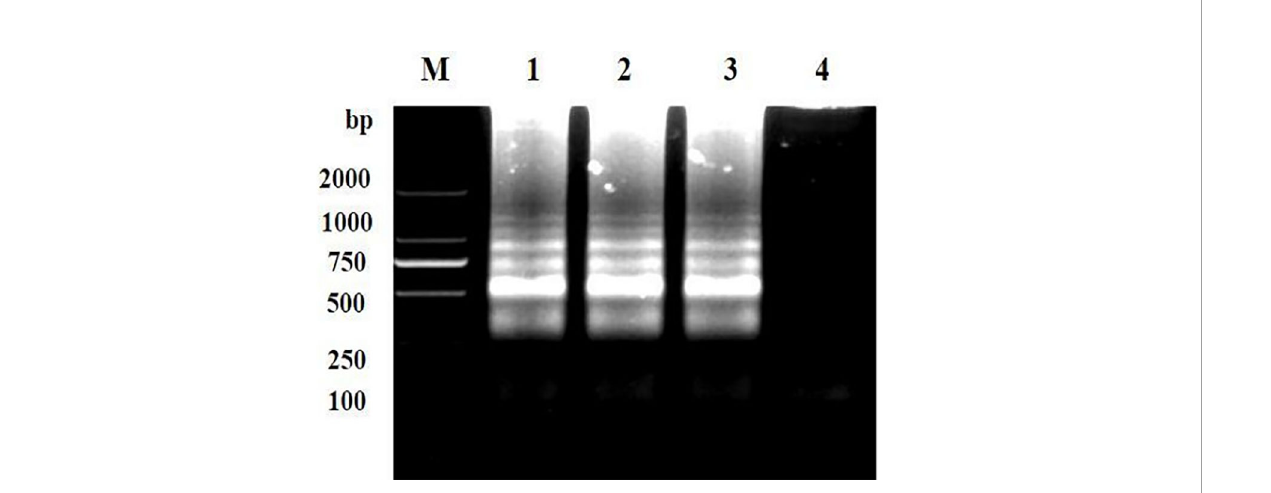
FIGURE 7 Repeatability detection of the LAMP assay for the detection of Brucella suis 52 vaccine strain. Assay products were visualized using gel electrophoresis. M, DNA marker DlL_2000; Lanes 1-3 are different batches of reagents and Lanes 4 is a negative control. The main components of the three batches of reagents are identical, but they are produced at different